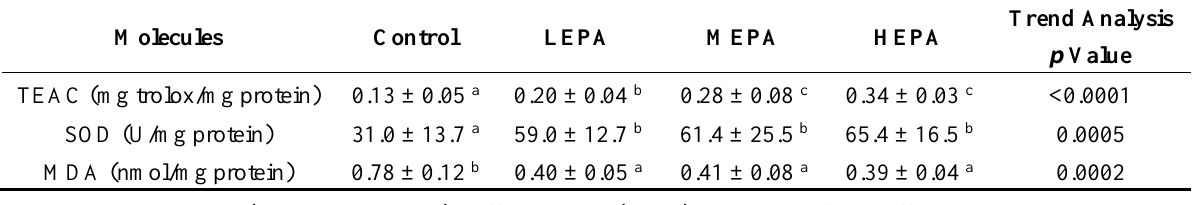
Table 3 . Effect of EPA on total antioxidant ability and superoxide dismutase (SOD) and malondialdehyde (MDA) activity in rats after exhaustive